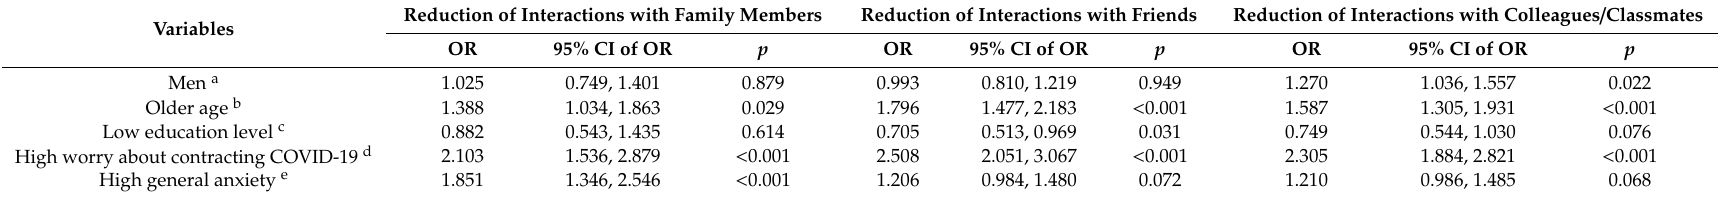
Table 3. Factors Associated with the Three Types of Reduced Social Interaction: Logistic Regression Analysis.